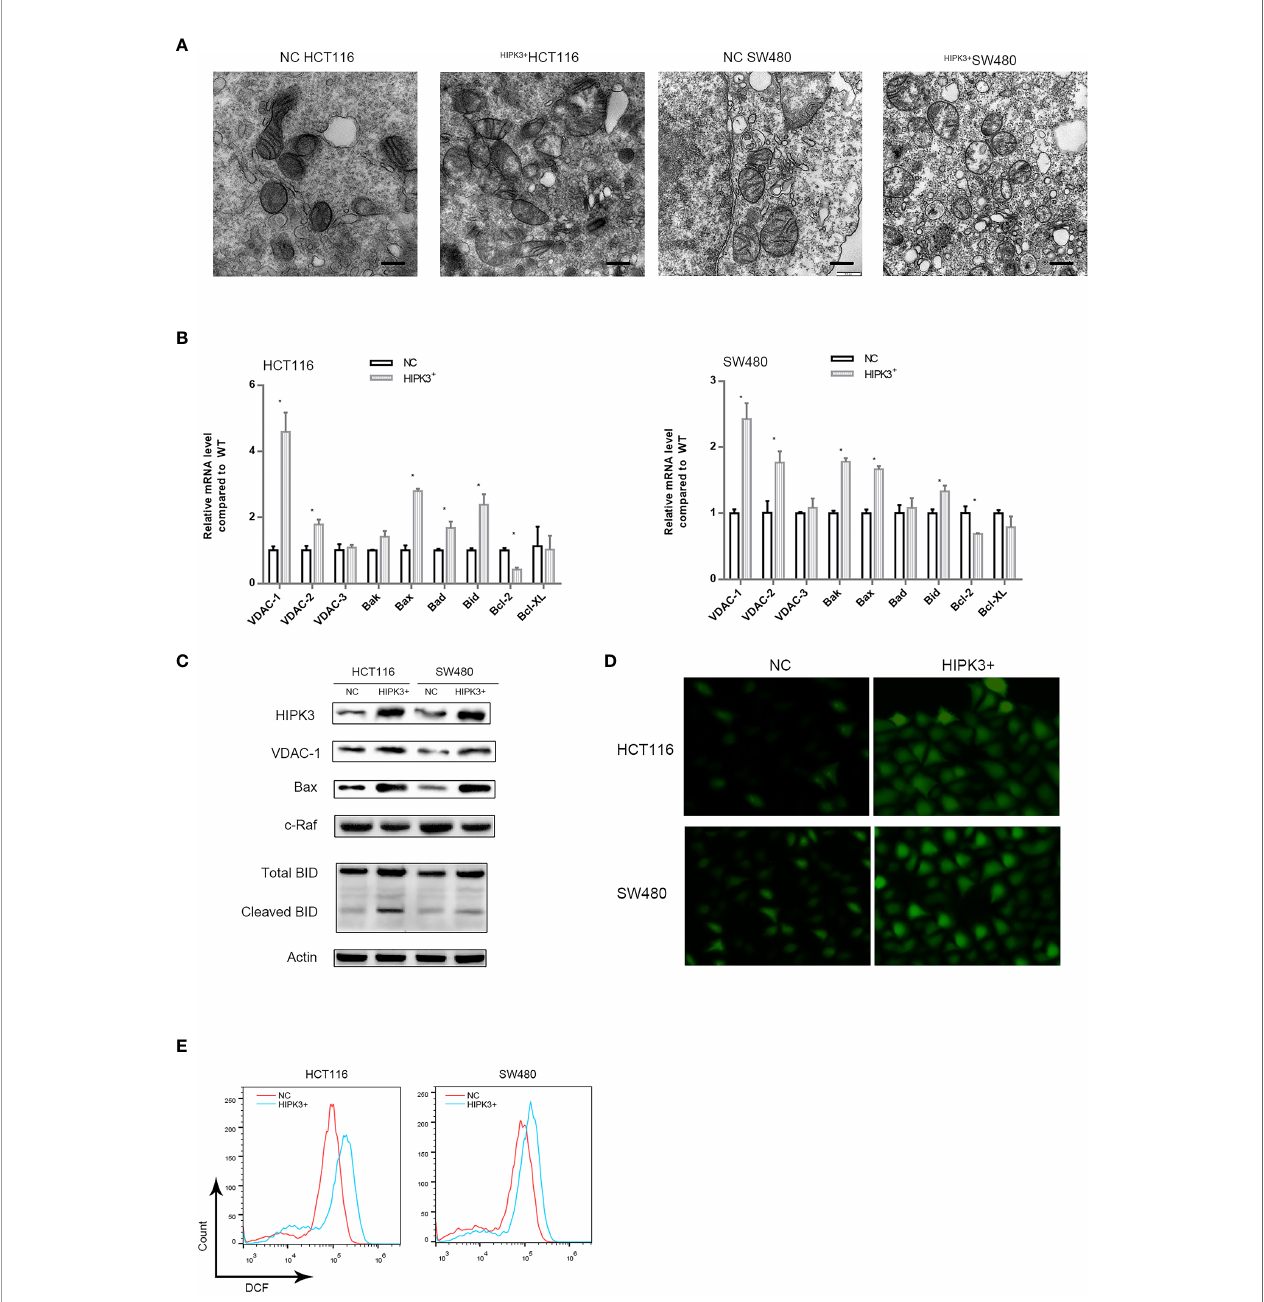
FIGURE 6 | Expression of key proteins related to apoptosis in mitochondria were altered in HCT116 and SW480 cells stably over-expressing HIPK3. (A) Transmission electron micrograph of mitochondria. (B) mRNA level of key proteins related mitochondria-mediated apoptosis. (C) Immunoblots of key enzymes in mitochondrial respiration. (D) ROS generation probed by DCFH-DA. (E) ROS quanti fi cation by fl ow cytometry (histogram). * correspond to a p-value less than